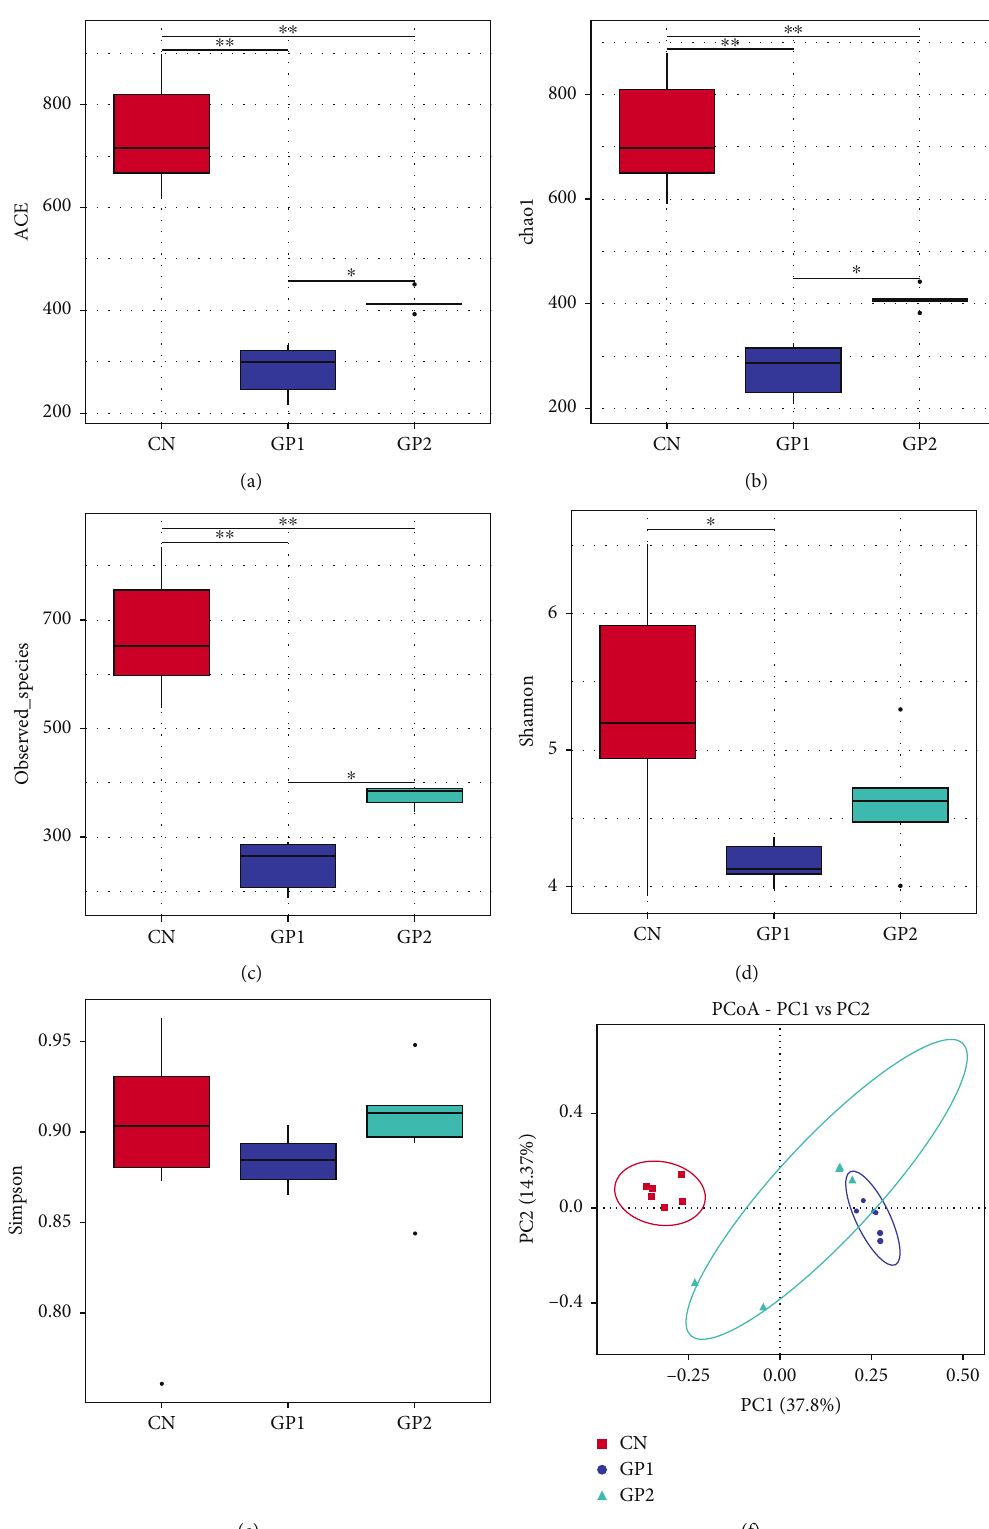
Figure 5: E ff ects of garlic powder inclusion on micro fl ora of intestinal content in Chinese mitten crabs. Bars assigned with di ff erent superscripts are signi fi cantly di ff erent ( P < 0 : 05 ). (a) ACE; (b) chao1; (c) observed species; (d) Shannon; (e) Simpson; (f)